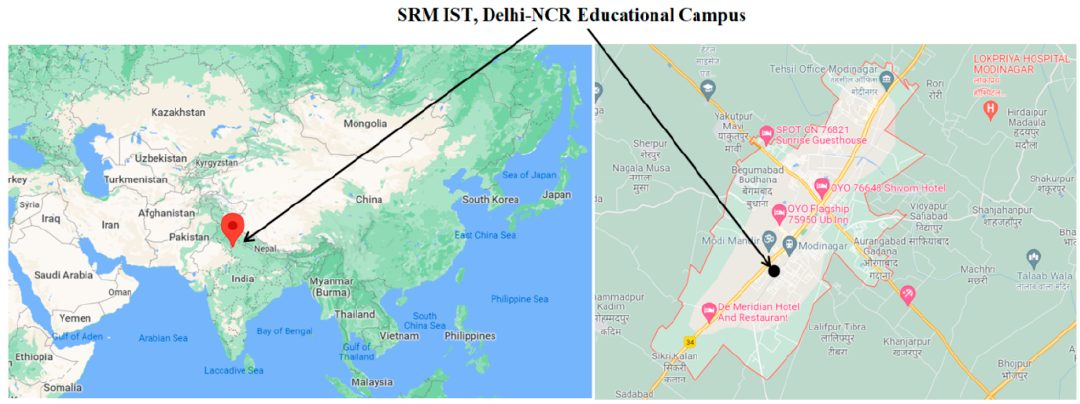
Figure 1. Map showing SRM IST, Delhi-NCR Educational Campus, South Central Asia.